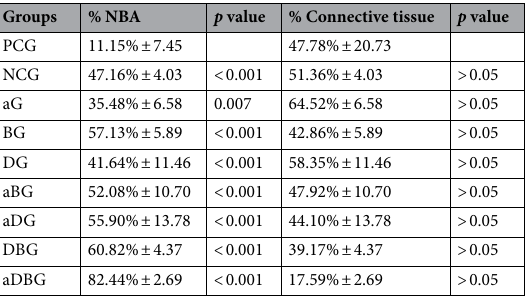
Table 1. Summarization of the % NBA and % connective tissue values with theirs respectively significances differences when compared to PCG.